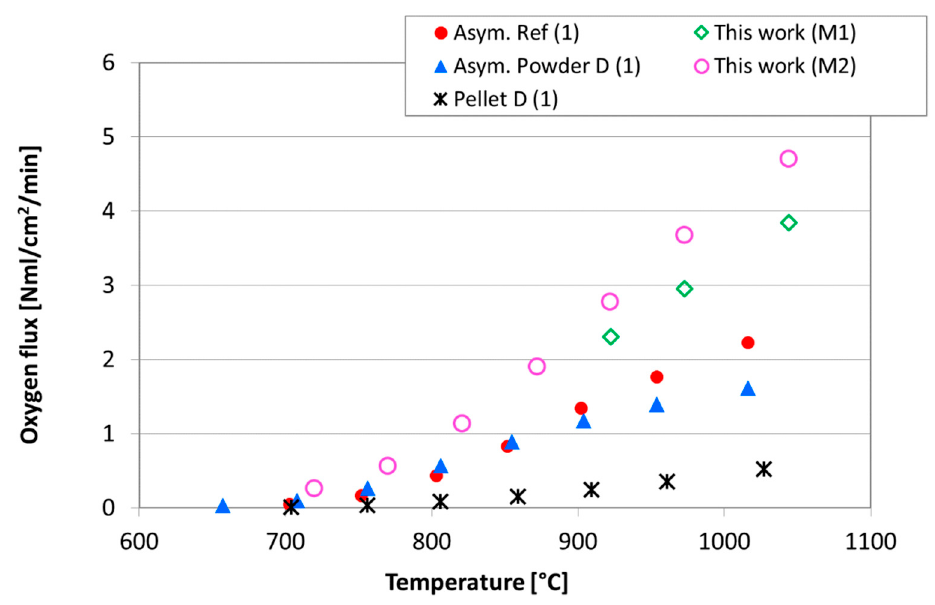
Figure 9. Comparison in terms of oxygen flux as a function of the temperature between samples tested in this work and in [4]. Tests performed by feeding air as process gas.